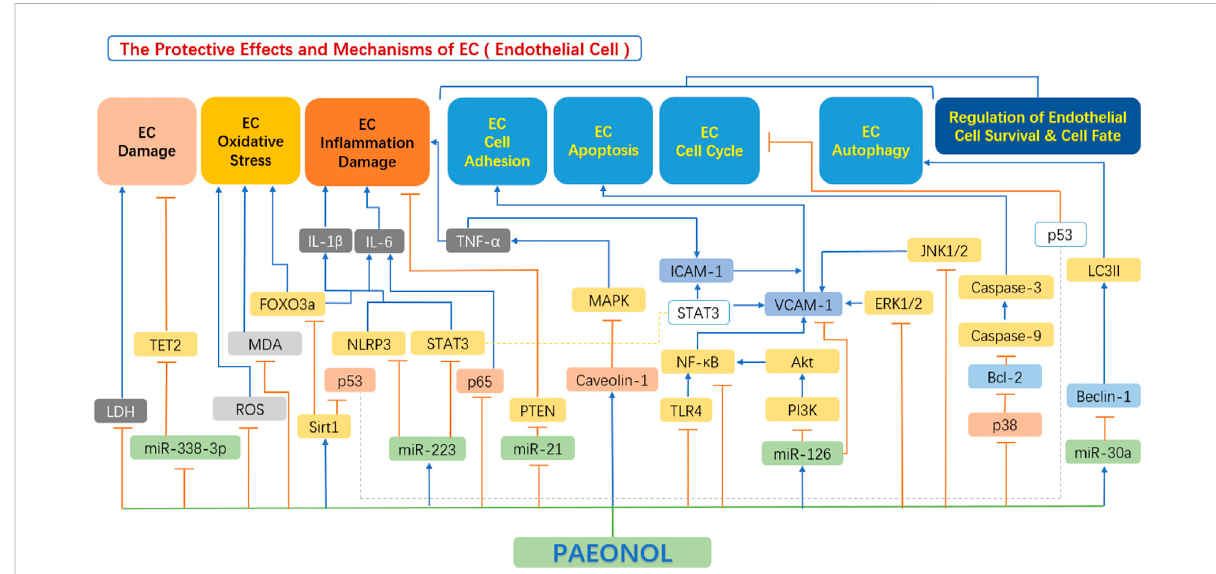
FIGURE 4 The protective effects and mechanisms of paeonol in endothelial cells. Akt, serine-threonine kinase; Bax, Bcl-2-associated X protein; Bcl-2, B-cell lymphoma-2; Beclin-1, the mammalian ortholog of yeast ATG6; ERK1/2, extracellular signal regulated kinase 1/2; FOXO3a, forkhead box transcription factor O3a; ICAM1, intercellular adhesion molecule 1; IL-1 β , interleukin 1 β ; IL-6, interleukin 6; JNK1/2, c-Jun N-terminal kinase 1/2; LC3II, lightchain 3II; LDH, lactatedehydrogenase; MAPK,mitogen-activated proteinkinase;MDA, malondialdehyde; miR-126, microRNA-126; miR-21, microRNA-21; miR-223, microRNA-223; miR-30a, microRNA-30a; miR-338-3p, microRNA-338-3p; NF- κ B, the nuclear factor kB; NLRP3, NOD-like receptor 3; p38, p38 mitogen-activated protein kinase (MAPK); p53, tumor protein p53 (also known as TP53); PI3K, phosphatidylinositol- 4,5-bisphosphate 3-kinase; ROS, reactive oxygen species; Sirt1, sirtuin 1; STAT3, signal transducer and activator of transcription 3; TET2, tet methyl cytosine dioxygenase 2; TLR4, toll-like receptor 4; TNF- α , tumour necrosis factor α ; VCAM1, vascular cell adhesion molecule